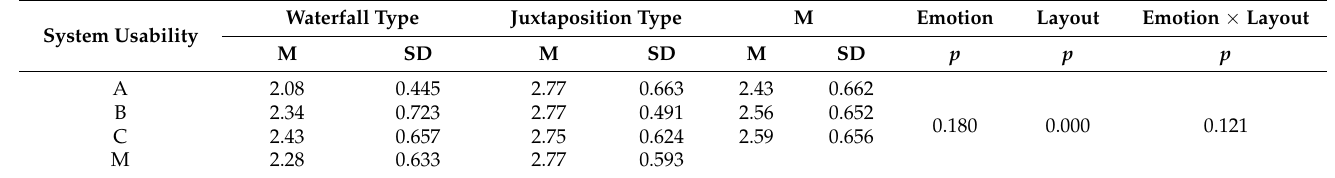
Table 9. Descriptive statistics and two-way ANOVA for system usability.